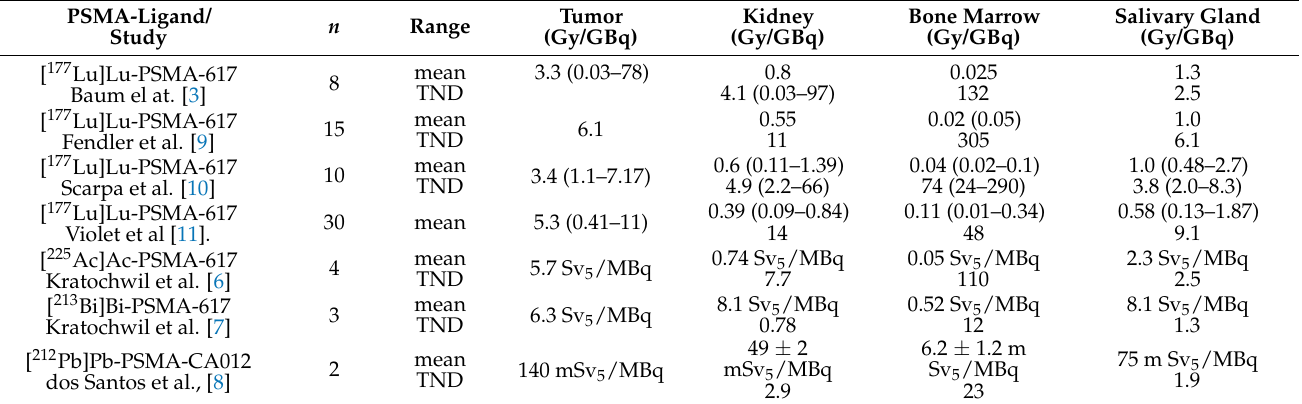
Table 1. Absorbed doses per administered activity and TNDs for kidney, bone marrow, and salivary glands after treatment with radiolabeled PSMA